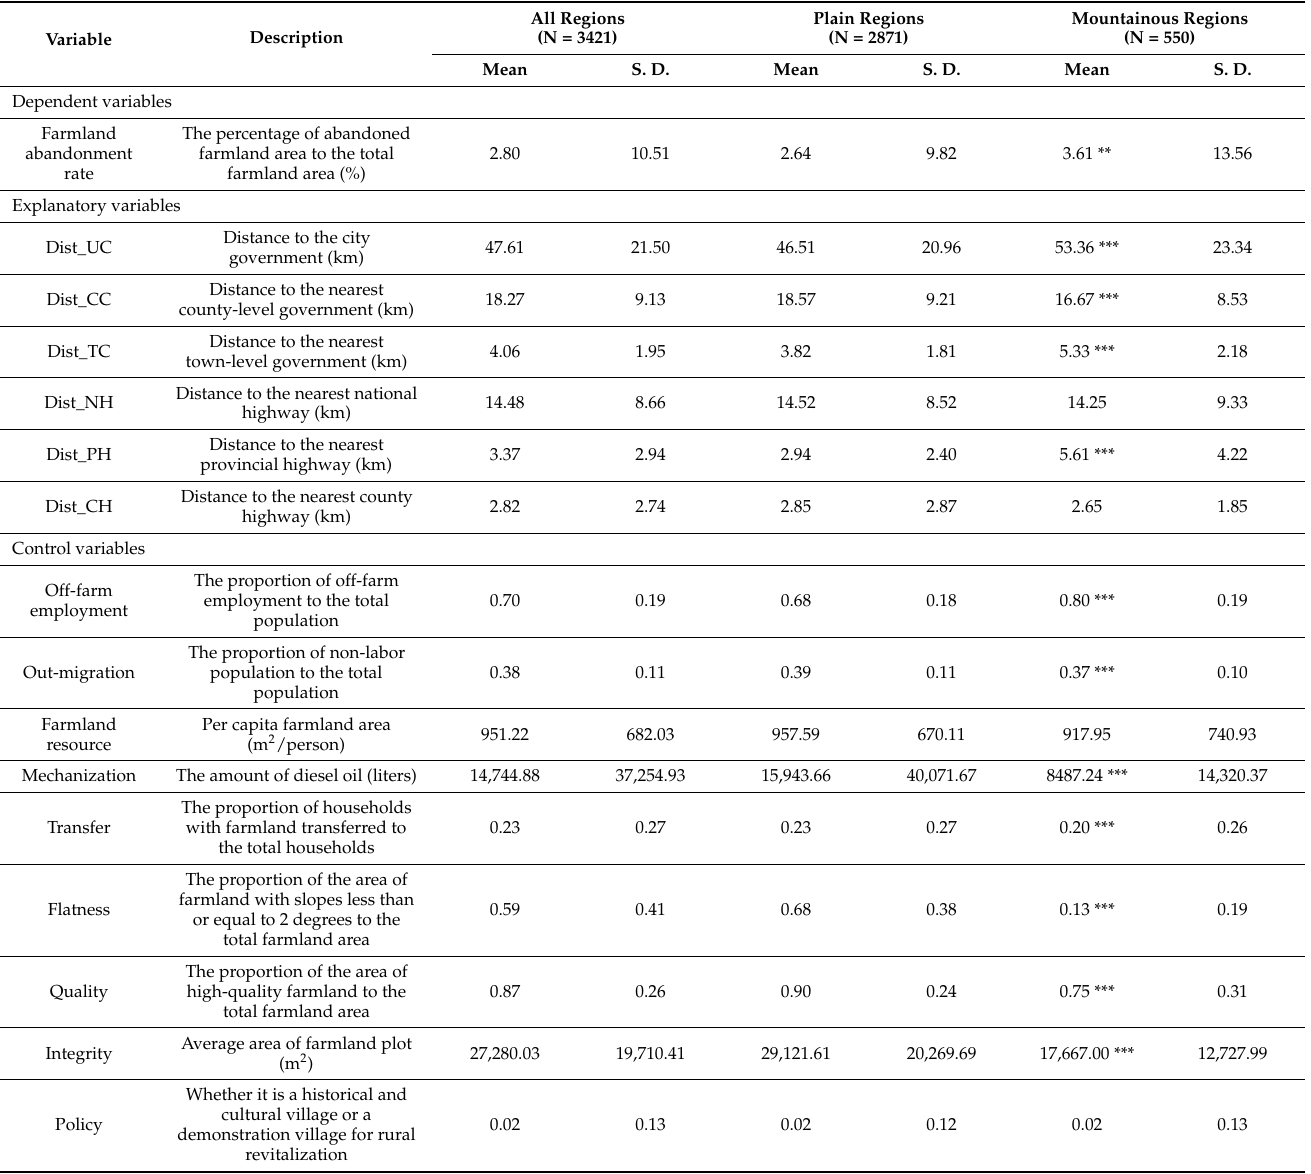
Table 2. Summary statistics of